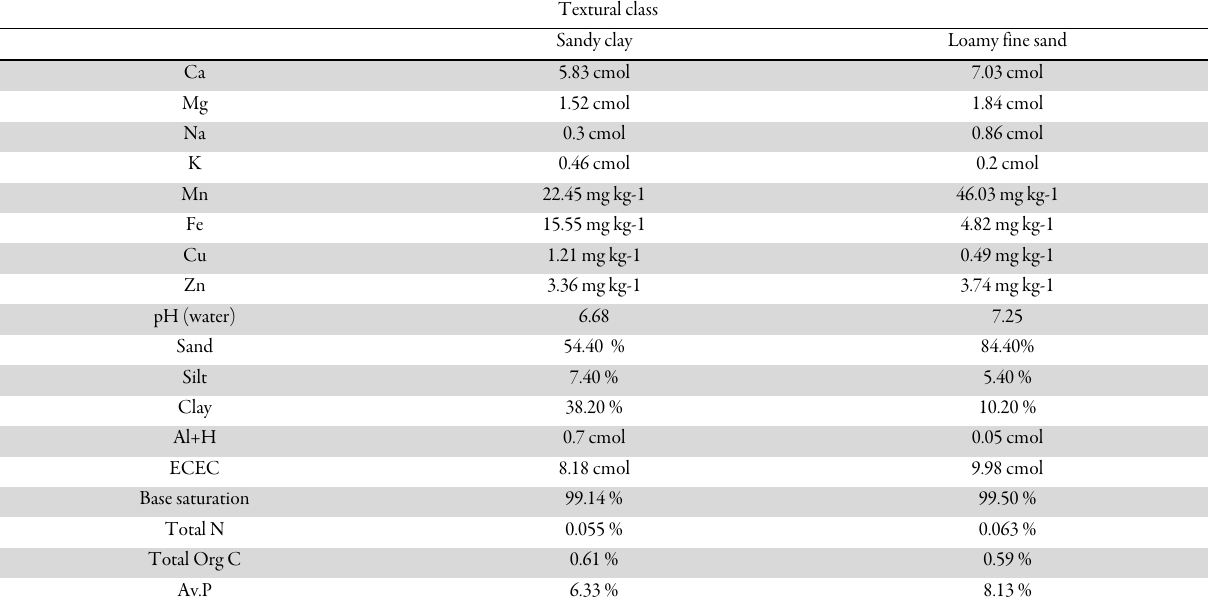
Table 1. Physical and chemical properties of soil used in this study